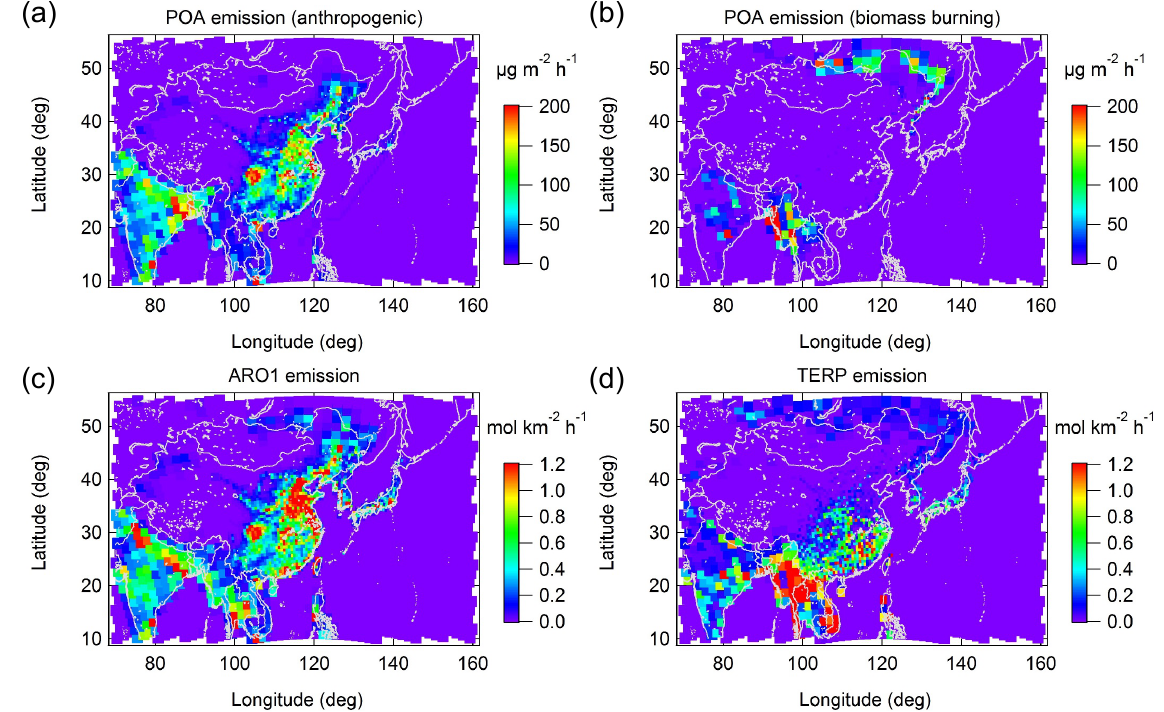
Figure 3. Period-averaged (24 March–26 April 2009) emissions for (a) POA from anthropogenic sources (fossil fuel and biofuel combustion), (b) POA from biomass burning sources, (c) ARO1 (aromatics), and (d) TERP (monoterpenes). We used the anthropogenic and volcanic emission inventories of Streets et al. (2003), daily biomass burning emissions of the Global Fire Emissions Database version 3 (GFED3) (van der Werf et al., 2010), and online biogenic emissions of the Model of Emissions of Gases and Aerosols from Nature version 2 (MEGAN2) (Guenther et al.,